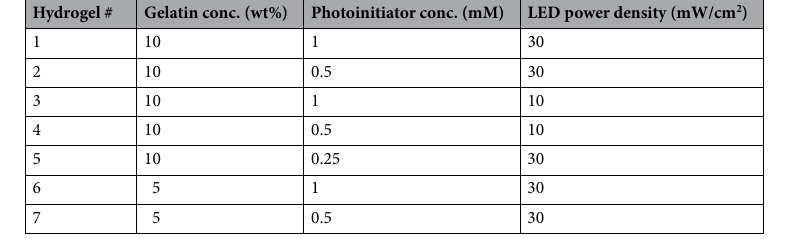
Table 1. The hydrogel and LED power density